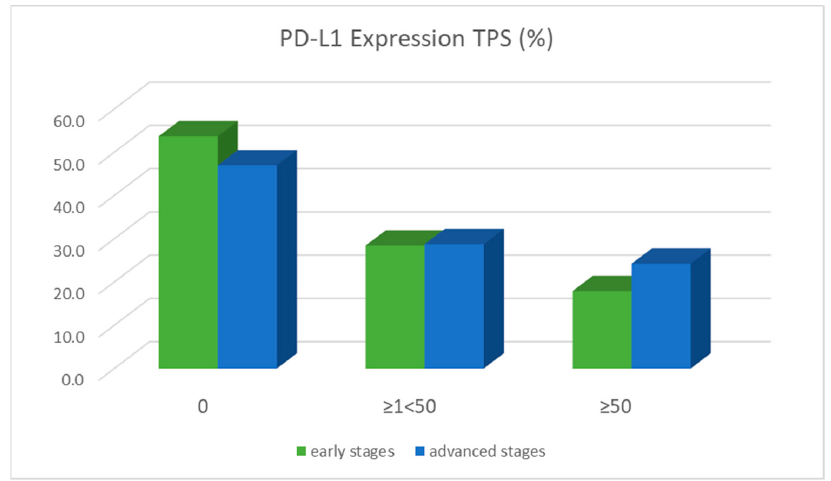
Figure 5. PD-L1 expression in early versus advanced tumor stages regarding the percentage of membrane-stained tumor cells (TPS score).